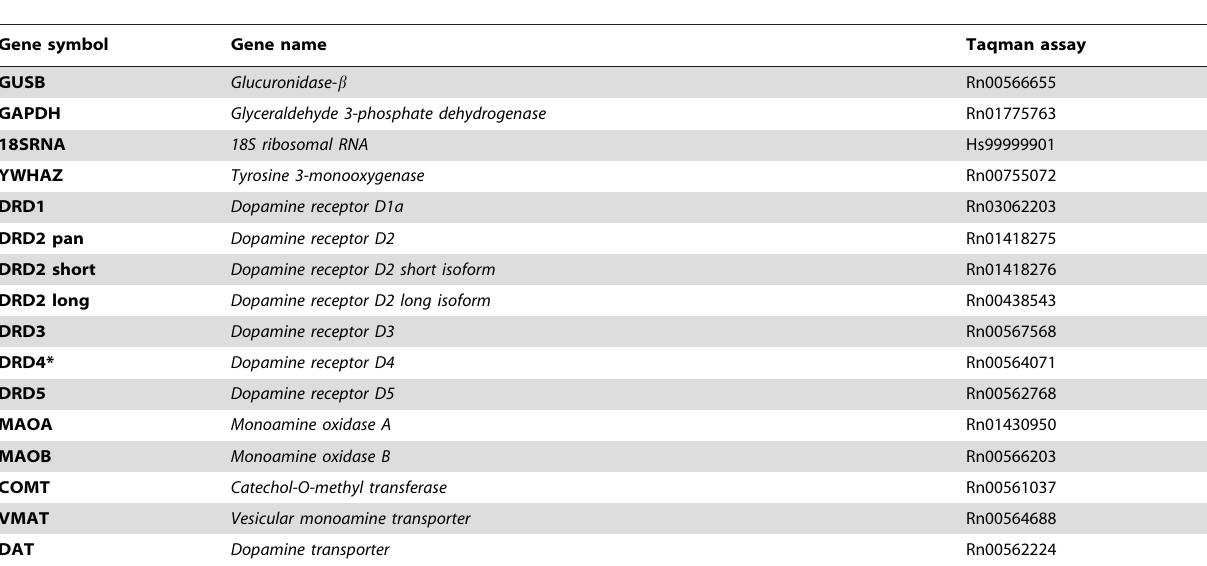
Table 1. Genes of interest and housekeeper genes with ABI Taqman Gene Expression Assay part numbers.